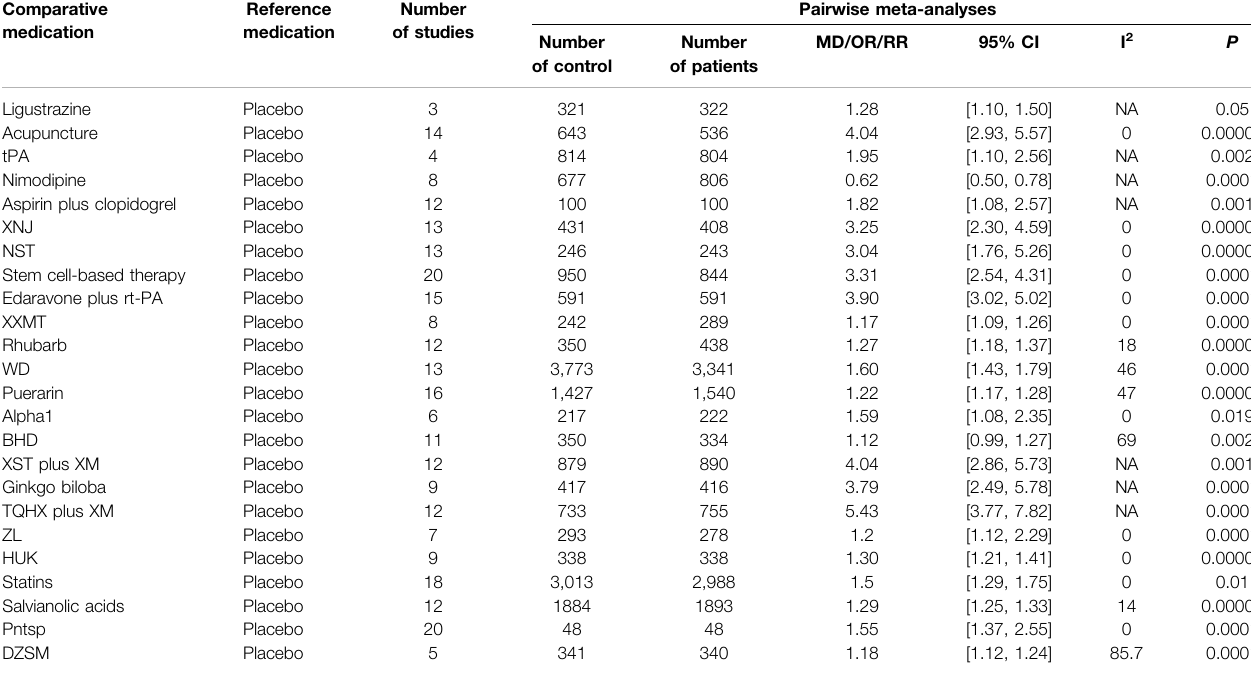
TABLE 2 | Results of pairwise meta-analyses for the clinical effect. Comparative